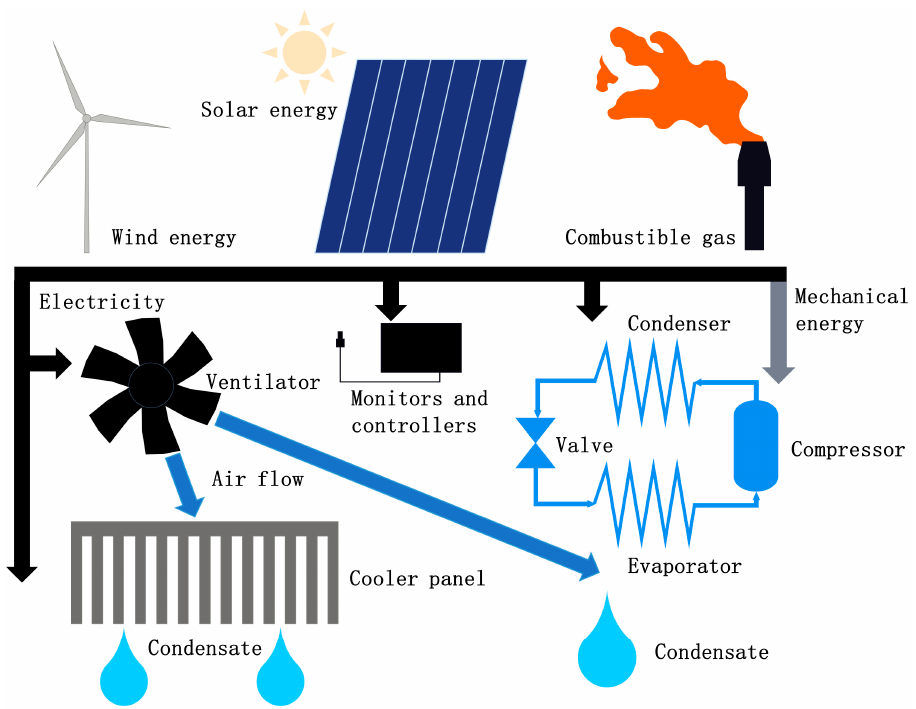
Figure 1. Schematic diagram of atmospheric water harvesting systems based on condensation.